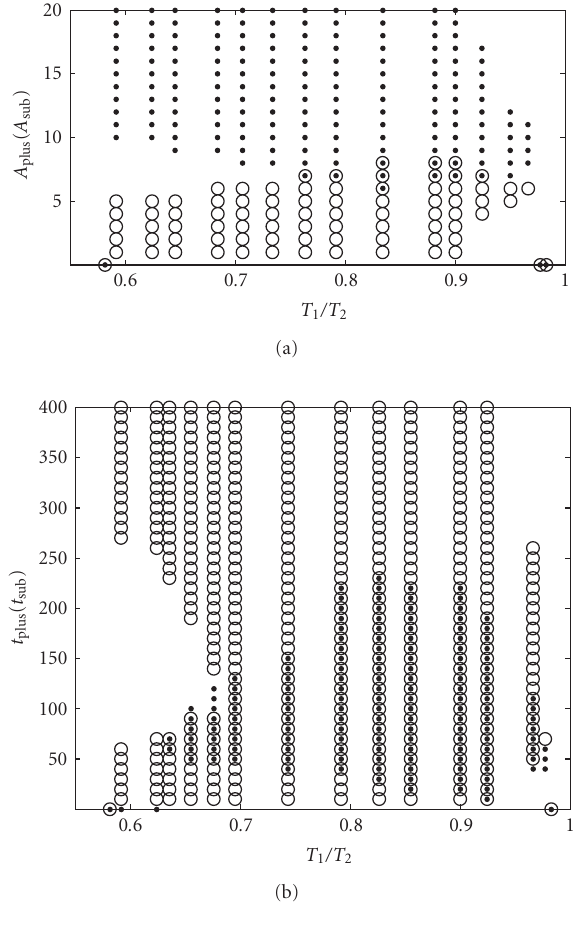
Figure 5: The range of learning parameters leading to synchroniza- tion for all 40 stimulations for c-STDP is presented. The points are the range of A plus and t plus which can make neuron synchronization. The circles are the range of A sub and t sub . We choose some values of T 2 to investigate the e ff ect of A plus , A sub , t plus and t sub on global synchronization. A plus and A sub vary from 1nS to 20nS. Let t plus and t sub vary from 10 milliseconds to 400 milliseconds. There are some values of T 1 / T 2 marked on the horizontal axis that cannot be entrained to achieve synchronization in Figures 5(a) and 5(b).